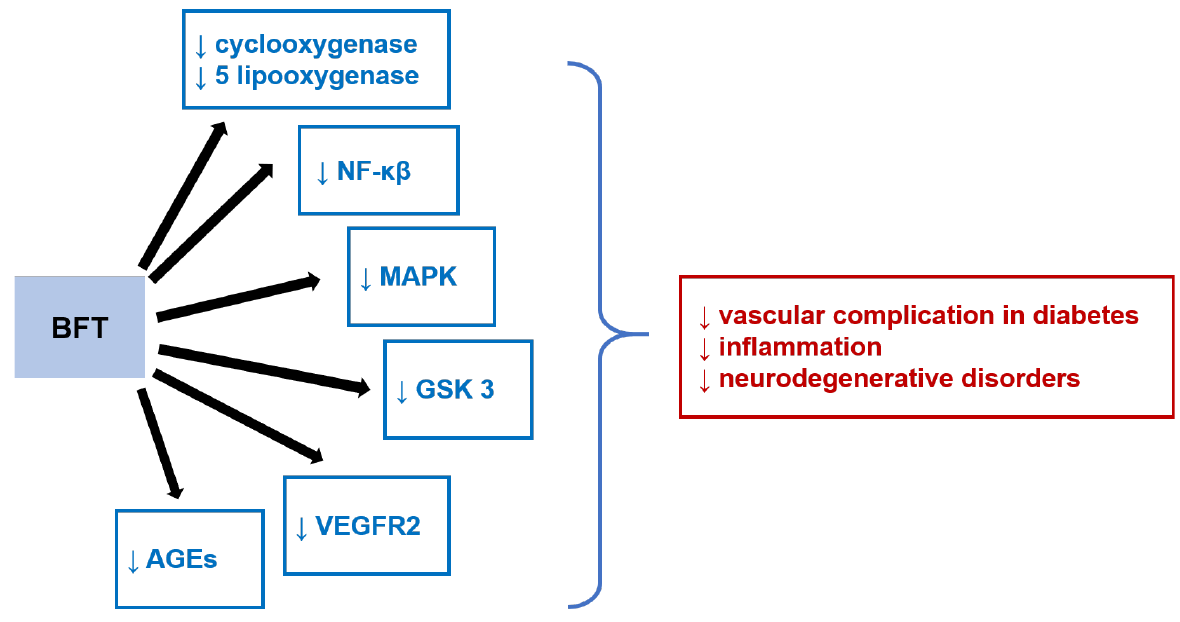
Figure 6. Other effects of benfothiamine. NF- κβ, nuclear transcription factor κB; MAPK, mitogen - activated protein kinases; GSK 3, glycogen synthase kinase-3; VEGFR2, vascular endothelial growth factor receptor 2; AGEs, advanced glycation end-products.